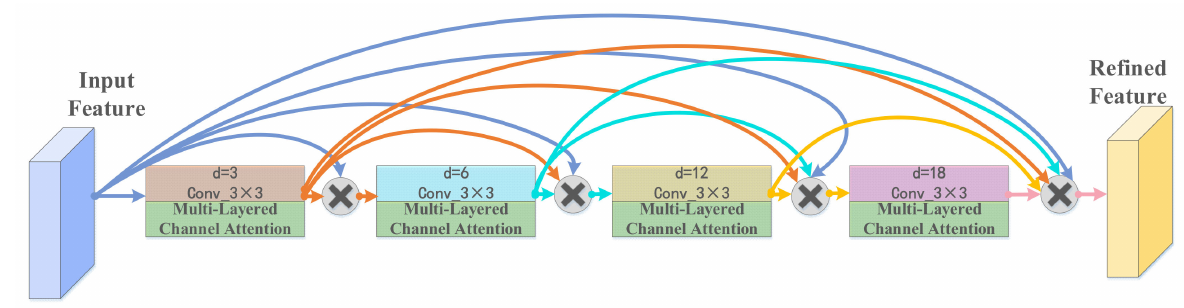
Figure 3. The detailed technical principles of an ADense